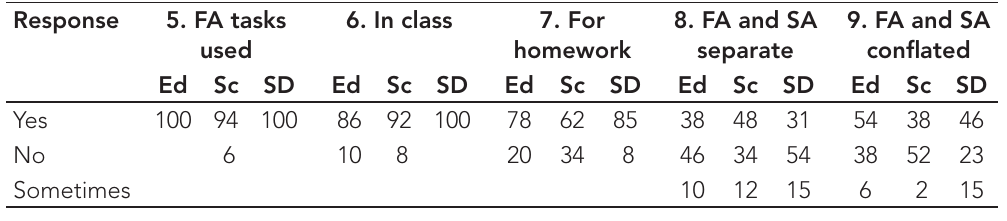
Table 6: Formative assessment tasks used with students (numbers in first row refer to question numbers)